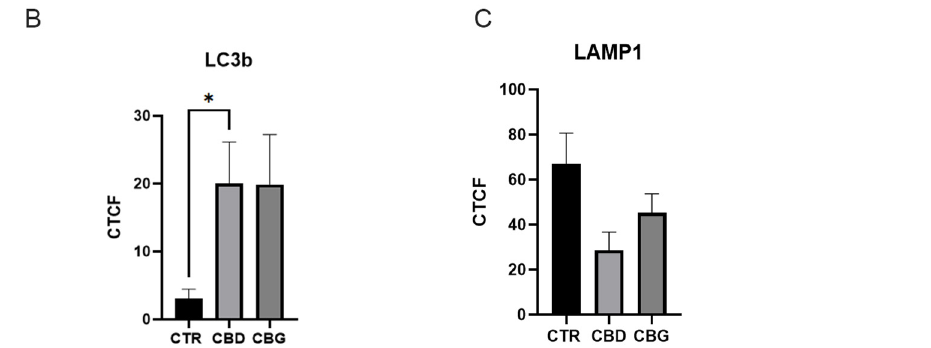
Figure 5. CBD and CBG treatment promoted autophagy in HuCC-T1 cells; ( A ). Alexfluor568 staining of LC3b (red) Alexfluor488 staining of LAMP1 (green), and DAPI staining (blue) of the nucleus for 0.1% DMSO (top), 100 µ M CBD (middle) and 100 µ M CBG (bottom) at 6 h post treatment; ( B ). graph showing quantification of LC3b fluorescence in all three groups with a significant increase in LC3b fluorescence with CBD treatment and an increase with CBG treatment ( p = 0.108); ( C ). graph showing quantification of LAMP1 fluorescence in all three groups with no significant changes between groups. CTCF: corrected total cell fluorescence. * p < 0.05 .